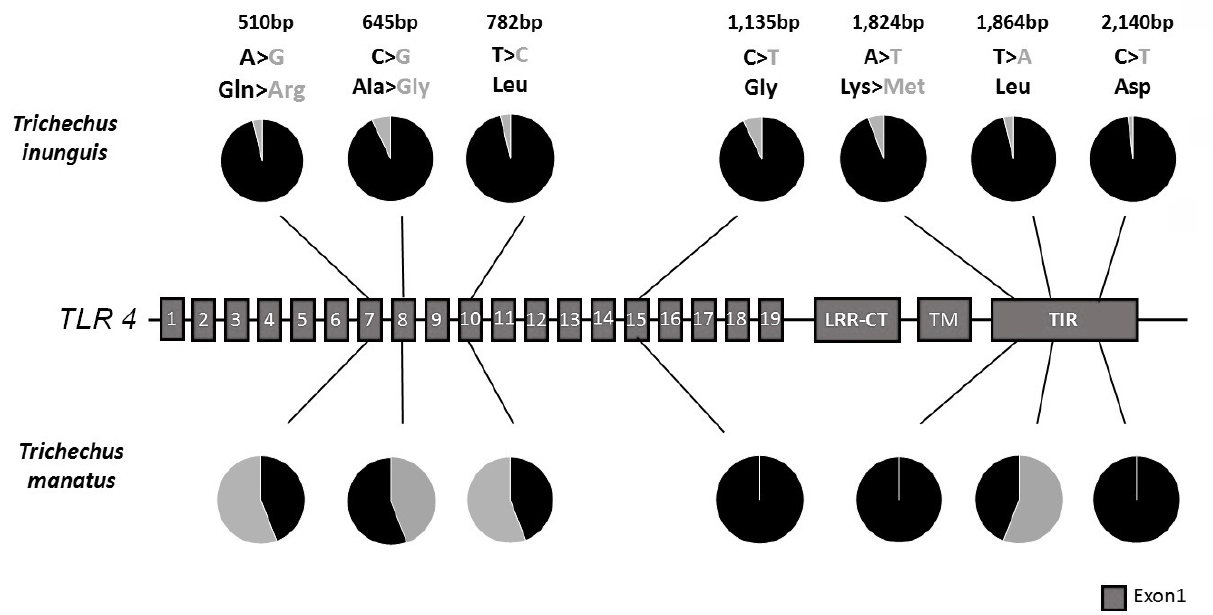
Figure 2 – Identification of SNPs in the structure of the TLR4 gene. In the graph the higher frequency of nucleotides is represented in black with synonymous and non-synonymous occurrences in two populations of manatees. The cartoon structure is represented by exon 1 (red). Rectangles represent LRRs (1-19), LRR-CT, trans-membrane (TM) and intracellular (TM)